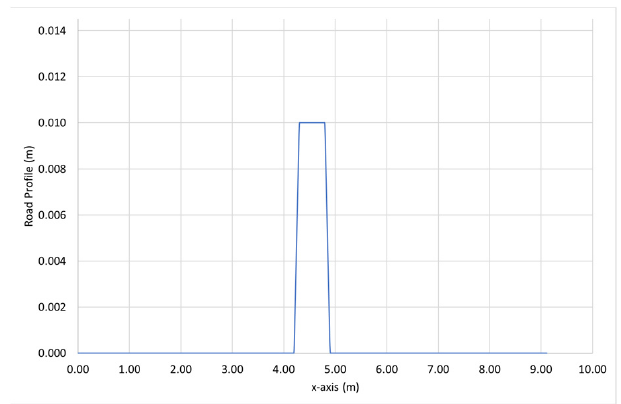
Figure 5. The bump excitation.